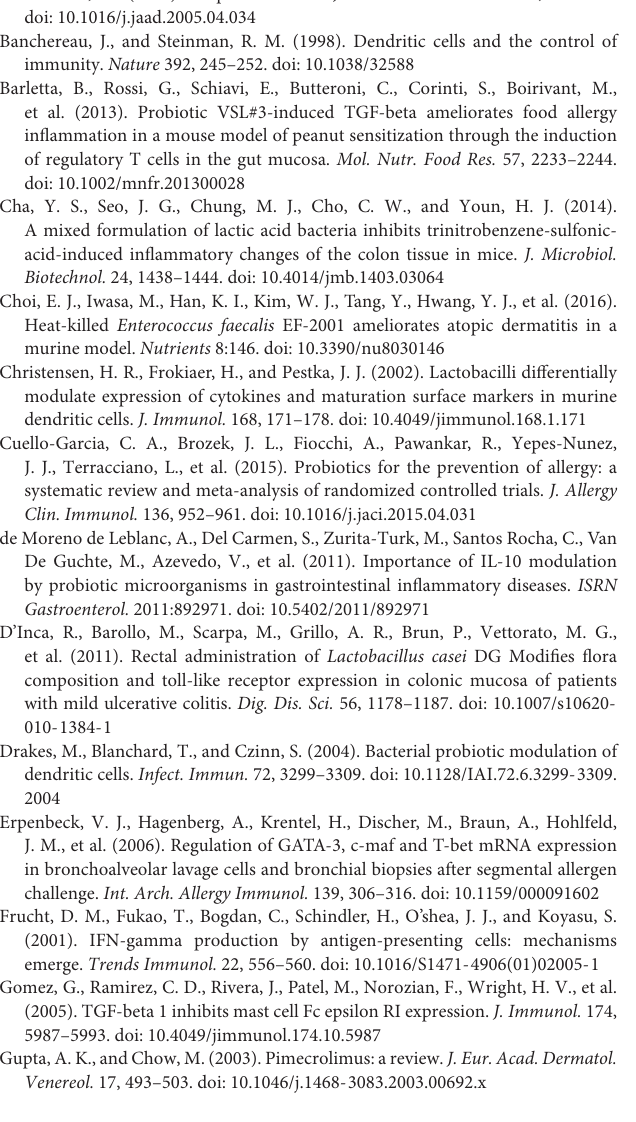
Body weight was monitored weekly for 4 weeks. (B) The spleen was isolated and weighted at week 4. FIGURE S5 | Cytokine expression changes in the AD mouse treated with Duolac ATP. NC/Nga mice were sensitized by exposure to DNCB twice a week for 3 weeks. They were then orally administered with PBS or Duolac ATP for 4 weeks. Blood samples were taken and serum (A) IFN-gamma and (B) TGF-beta levels were measured by ELISA. Data are representative of at least three experiments. ∗ P < 0.05 using one-way ANOVA with Tukey’s multiple comparison test. Bars indicate mean ± SEM. FIGURE S6 | Subpopulation of DC from mLN and PP in the AD mouse treated with Duolac ATP. NC/Nga mice were sensitized by exposing DNCB twice a week for 3 weeks. The mice were then orally administered PBS or Duolac ATP for 4 weeks. (A) mLN and (B) PP collected at week 4 were used to make single cells. The cells were gated on CD11c and subdivided based on CD11b and CD103 expression using flow cytometry. Data are representative of at least three